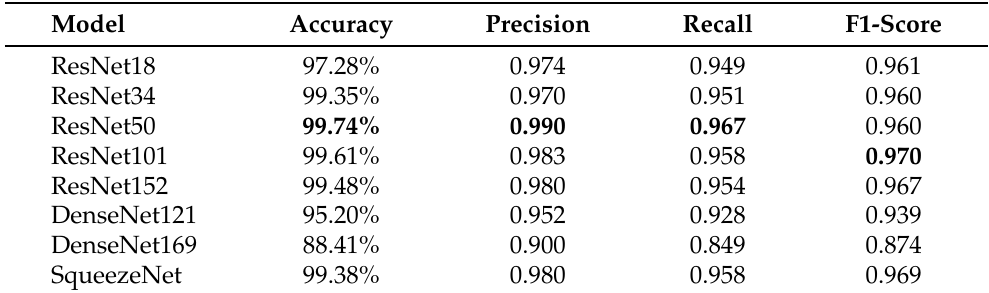
Table 2. Validation accuracy achieved by different models. Bold font is used to highlight the best performance according to different criteria (columns).